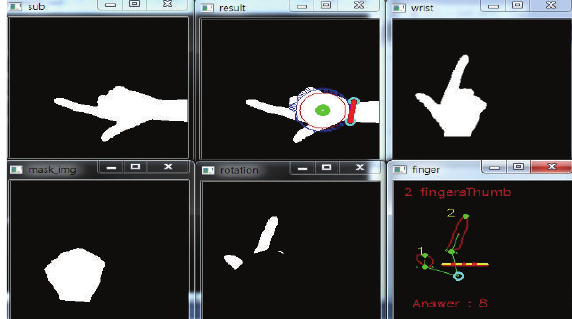
Figure 17: The recognition of the hand gesture 8.